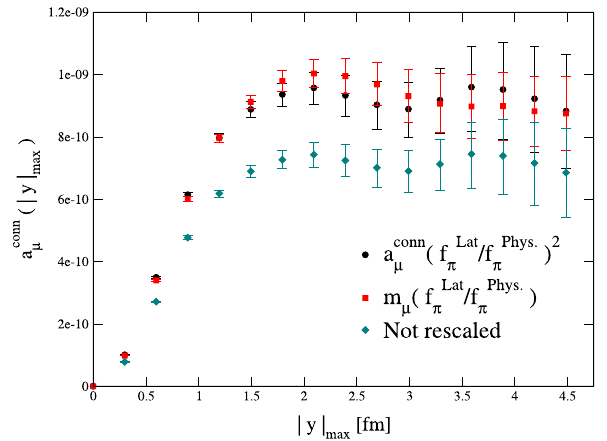
Fig. 16 Partially-integrated lattice results for the ensemble H101 with and without re-scaling of the integral